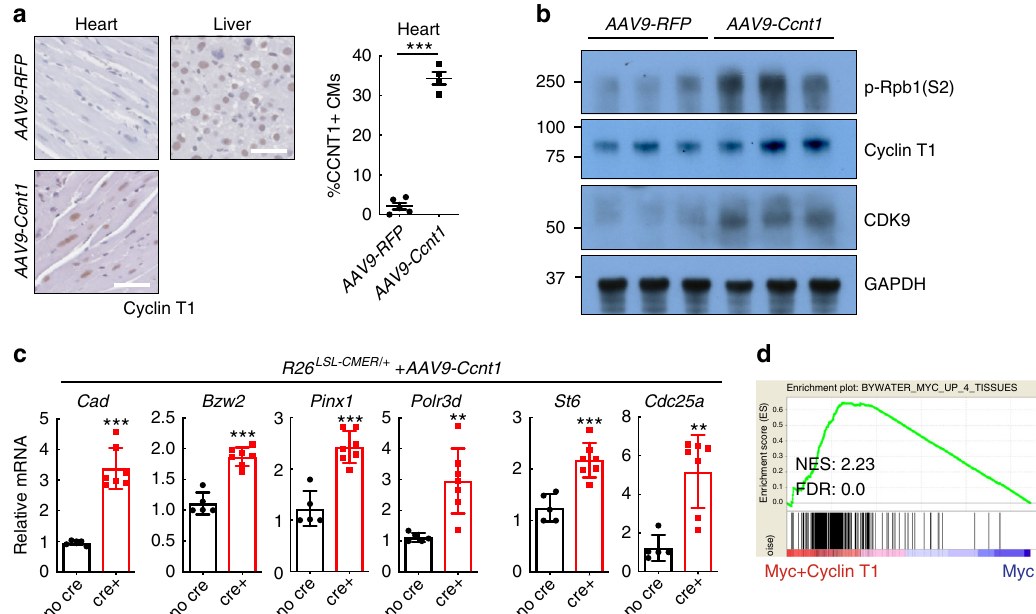
Fig. 8 Overexpression of Cyclin T1 in the adult heart facilitates Myc-driven transcription in adult cardiomyocytes. a Immunohistochemistry (left) and quanti fi cation (right) of Cyclin T1 in the liver isolated from adult R26 CMER/ + or heart isolated from Myh6-Cre ; R26 LSL-CMER/ + mice systemically infected with adeno-associated virus (serotype 9, 1 × 10 11 vg/mouse) encoding either RFP ( AAV9-RFP , n = 5) or Ccnt1 ( AAV9-Ccnt1 , n = 4) 4 weeks post infection. Mean and s.e.m shown. Unpaired t -test; AAV9-RFP vs AAV9-Ccnt1 : *** P < 0.0001. Representative images based on analysis of fi ve independent mice. b Immunoblot analysis of the C-terminal domain of phosphorylated RNA polymerase II (p-Rpb1(S2)), CDK9 and Cyclin T1 expression in the heart isolated from adult Myh6-Cre ; R26 LSL-CMER/ + mice systemically infected with adeno-associated virus encoding either RFP ( AAV9-RFP ) or Ccnt1 ( AAV9-Ccnt1 ) 4 weeks post infection. Replicate samples are derived from independent mice. c Quantitative RT-PCR analysis of Cad , Bzw2 , Pinx1 , Polr3d , St6 and Cdc25a expression in control ( R26 LSL-CMER/ + ; no cre, n = 5) and Myh6-Cre ; R26 LSL-CMER/ + ( R26 LSL-CMER/ + ; cre + , n = 7) adult mouse heart isolated 4 weeks post systemic infection with an adeno-associated virus encoding Ccnt1 ( AAV9-Ccnt1 ) and 4 h post administration of 4-OHT. Expression is relative to the respective wild type (R26 LSL-CMER/ + ) . Mean and s.e.m shown. Unpaired t -test; no cre vs cre + : *** P < 0.0005 ( Cad , Bzw2, Pinx1 and St6 ), ** P = 0.0013 ( Cdc25a ), ** P = 0.0035 ( Polr3d ). Replicate samples are derived from independent mice. d Enrichment of common Myc targets (liver, lung, kidney and heart) in cardiomyocytes isolated from the heart of AAV-CCNT1 infected Myh6-cre ; R26 LSL-CMER/ + (Myc + Cyclin T1) mice in comparison to uninfected Myh6-cre ; R26 LSL-CMER/ + mice (Myc) at 4 h post administration of 4-OHT, as determined by RNA sequencing. Including normalised enrichment score (NES) and FDR q -value